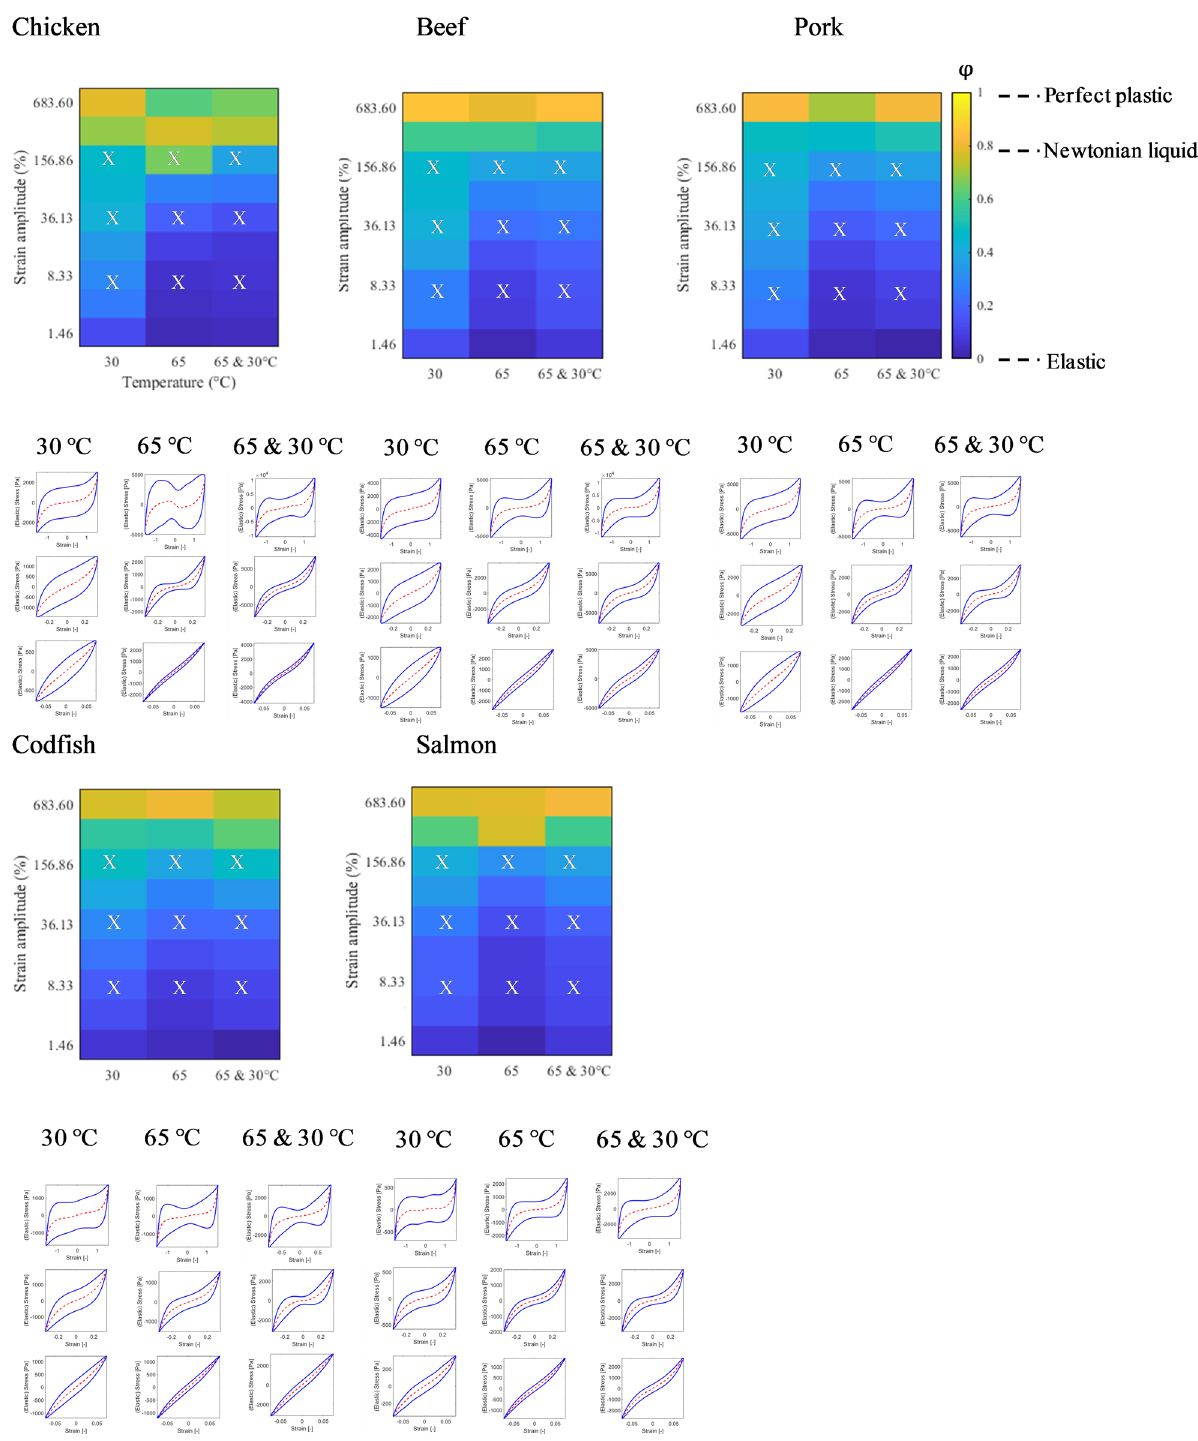
Figure 4. Colour scheme of the dissipation ratio ( ϕ ) in a strain–temperature diagram for meat and fish at 30 °C, heated at 65 °C, and heated at 65 °C and cooled to 30 °C. The colour corresponds to the value of the dissipation ratio ( ϕ ) in the colour bar, ϕ = 0, elastic; ϕ = π/4, Newtonian liquid; ϕ = 1, perfect plastic. Lower part: Lissajous curve of stress versus strain amplitude at three different strain amplitudes corresponding to the X symbol in the upper panel (individual plots of normalized stress [solid lines] and elastic stress [dashed lines] vs.